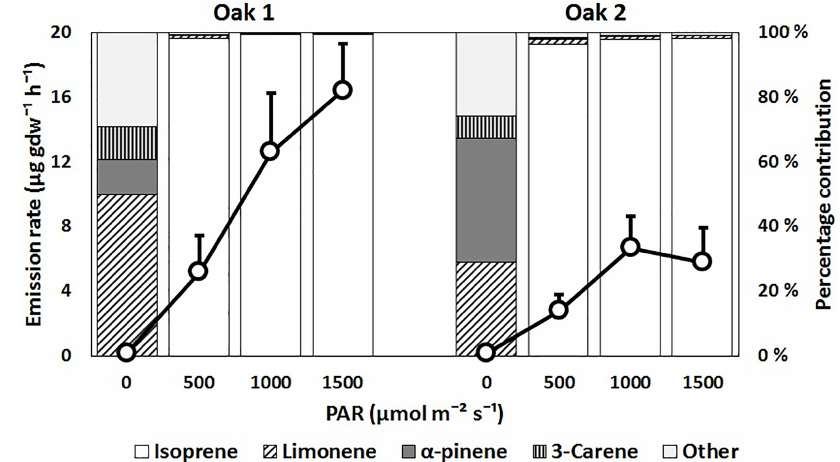
Figure 1. The total BVOC emission rate of two individual English oak trees (open circles) and the relative contribution of the major com- pounds at four intensities of photosynthetically active radiation (PAR). The error bars show the SD, n = 3–5 leaves. The category “Other” contains the compounds tricyclene, camphene and eucalyptol.